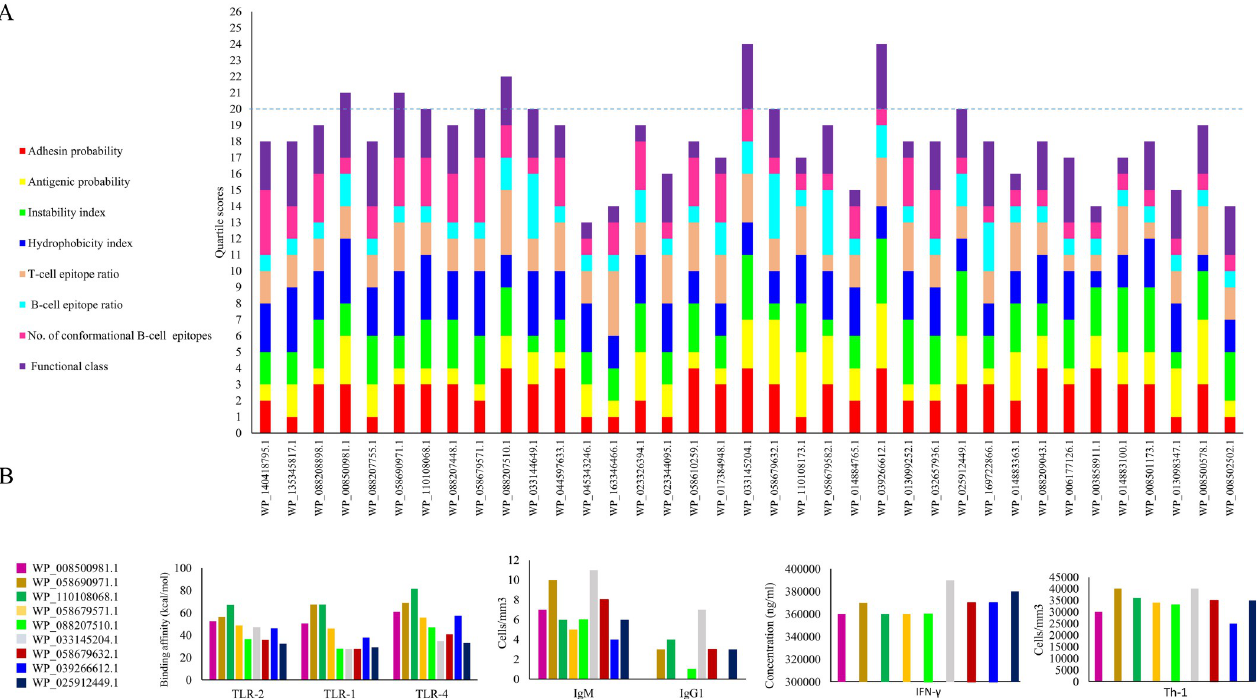
Fig 4. A. The comparison of 37 proteins of E . cloacae complex based on the quartile method. Nine proteins with a score of � 20 were considered as the shortlisted proteins based on the following eight properties: adhesion probability, antigenicity index, hydropathy index, instability index, functional class (virulence, cellular process, information and storage, and metabolic molecule), B-cell epitopes ratio, T-cell epitopes ratio, and the number of conformational B- cell epitopes. B. The comparison of immunological responses induced by nine shortlisted vaccine candidates against E . cloacae complex as well as their binding affinity to TLRs. The results showed that five proteins including WP_058690971.1, WP_110108068.1, WP_033145204.1, WP_058679632.1 and WP_025912449.1 could stimulate the production of IFN- γ , IgM, IgG1. Among these, WP_058690971.1 and WP_110108068.1 had the highest binding affinity to TLR-1, 2 and 4. extracellular proteins including WP_088207510.1 (flagellar hook-associated protein FlgK), WP_033145204.1 (flagellar hook protein FlgE), WP_058679632.1 (flagellar hook length con- trol protein FliK), and WP_039266612.1 (spore-coat U domain-containing protein). See Fig 4A.